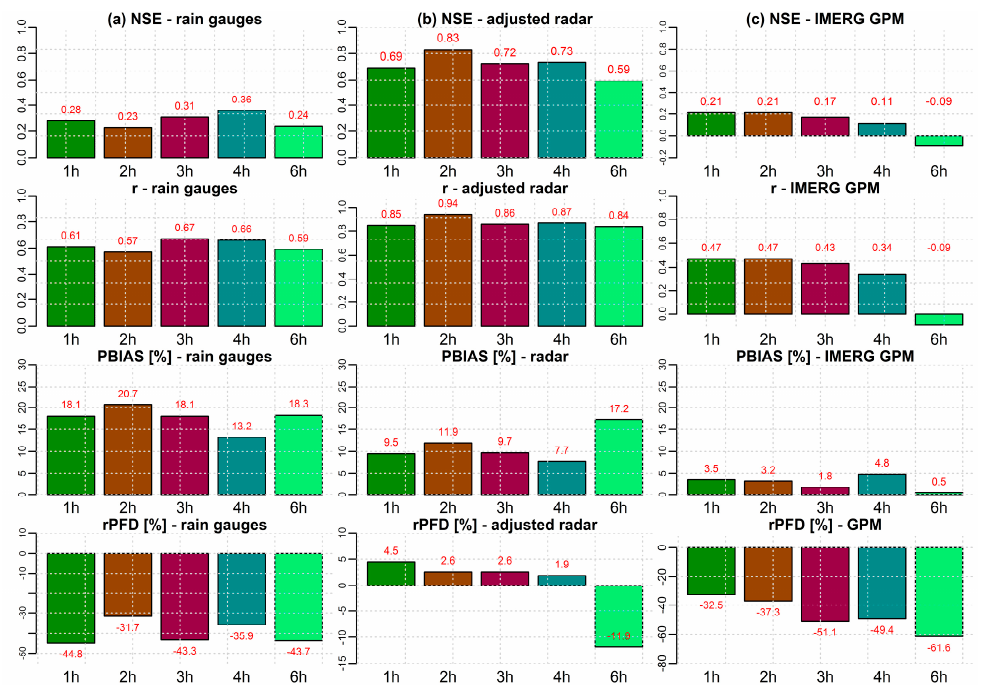
Figure 8. Comparison of the evaluation metrics performance (in columns) for Event 3 for aggregated time-steps simulations based on ( a ) rain gauge precipitation, ( b ) adjusted radar rainfall estimates, ( c ) IMERG GPM satellite rainfall estimates.